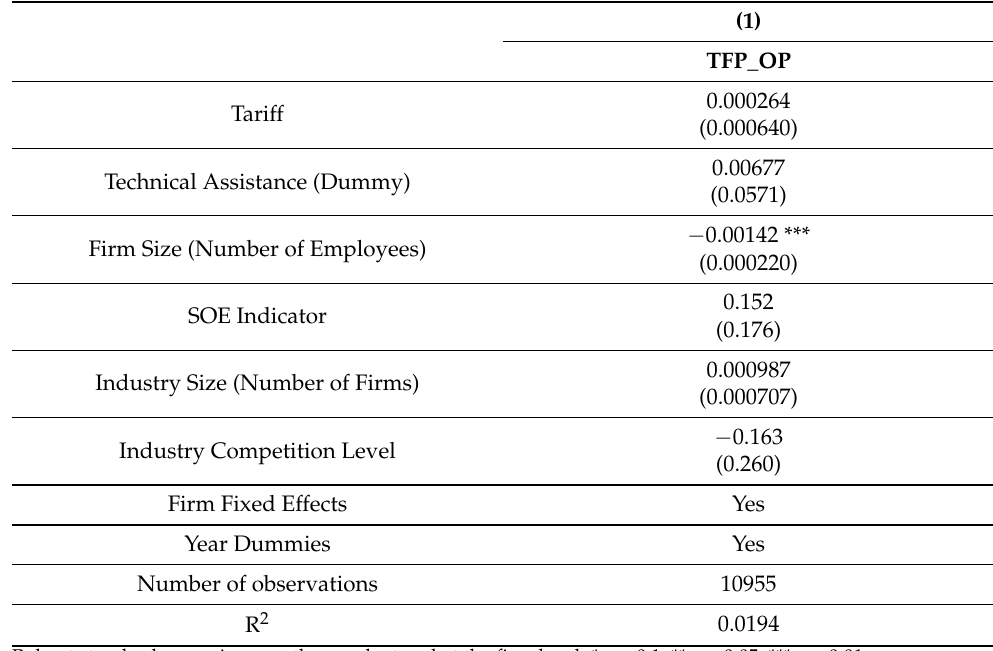
Table 13. Robustness Checks with Tariff Rates at the Industry Level as Additional Policy